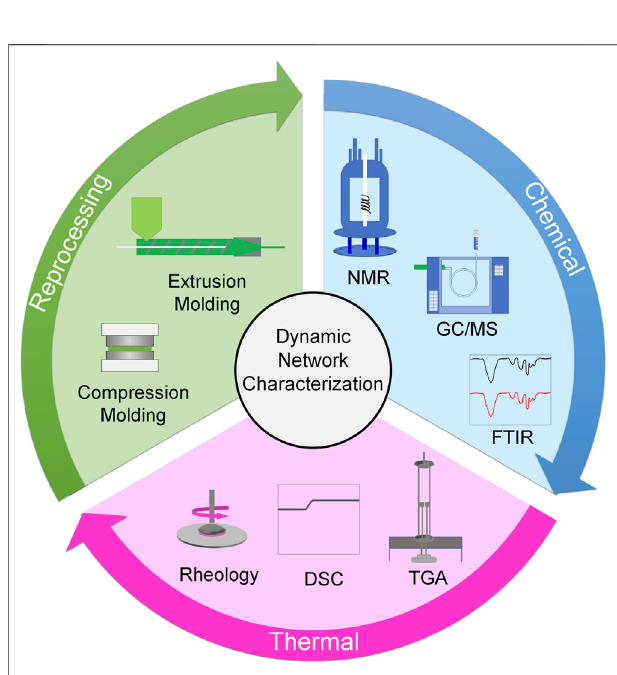
Frontiers in Materials |